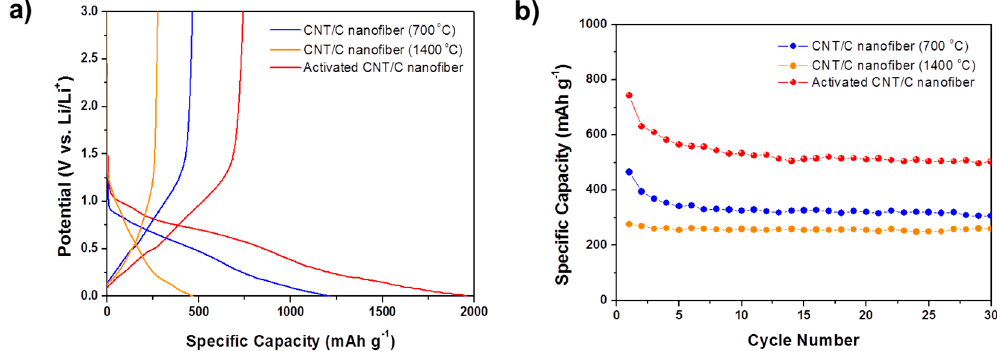
Figure 6. Electrochemical behaviors of the various types of CNT-carbon nanofibers: ( a ) Initial charge/discharge curves; and ( b ) Cycle performance of the 1 wt % CNT-carbon nanofibers.